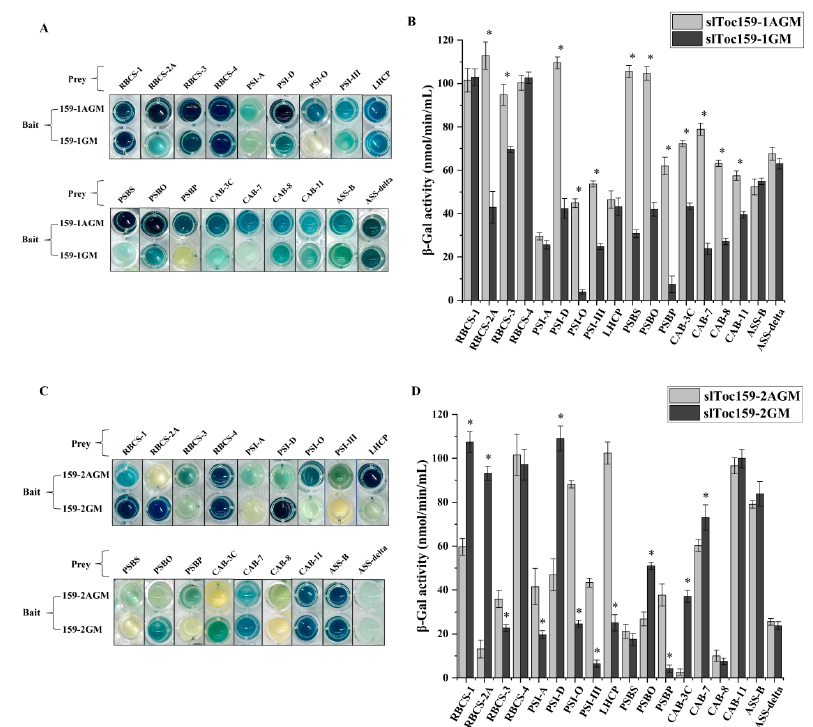
Figure 5. Interactions of photosynthesis-related prey proteins with four bait proteins (slToc159-1AGM, slToc159-1GM, slToc159-2AGM, slToc159-2GM) using the PXG and ONPG assays. ( A , C ) Independent transformants were assayed per protein interaction, scanned image of a PXG assay in a 96-well microtiter plate after 60 min of incubation. ( B , D ) Quantitative b-galactosidase activity assay. Strains co-expressing respective bait and prey constructs were used in a 96-well microtiter plate-based β -galactosidase assay using (X-Gal) as a substrate. The graph shows β -galactosidase activity/mL per min measured after 60 min. The values represent the mean of three independent experiments. β -gal, β -galactosidase; PXG, pellet X-gal; ONPG, O-nitrophenyl β -d-galactopyranoside; X-gal, 5-bromo-4-chloro-3-indolyl- β -d-galactoside. Values marked with asterisks are significantly different (Student’s t -test; p ≤